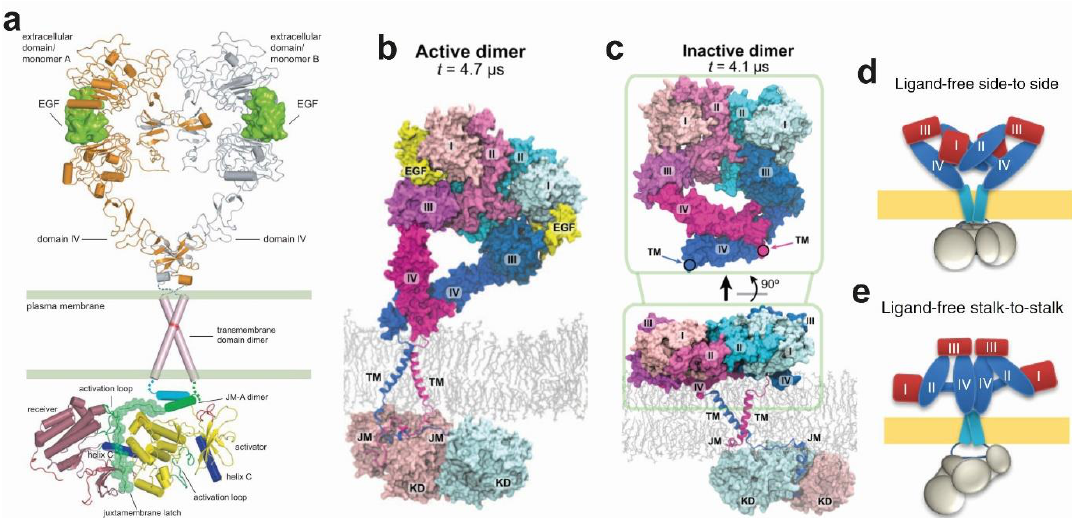
Figure 6. ( a ) Full EGFR model in which the ECM and intracellular module (ICM) meet across the membrane, the only gap being the short outer JM segment. Taken, with permission, from Jura et al. [177]. ( b , c ) simulation of the near full-length active and inactive dimers, respectively. Taken, with permission, from Arkhipov et al. [67]. ( d , e ) models for alternative dimers produced by a combination of high-resolution imaging methods, including fluorescence localization imaging with photobleaching (FLImP), Förster resonance energy transfer (FRET), and single particle tracking and atomistic MD simulations. Taken, with permission, from Zanetti-Domingues et al.